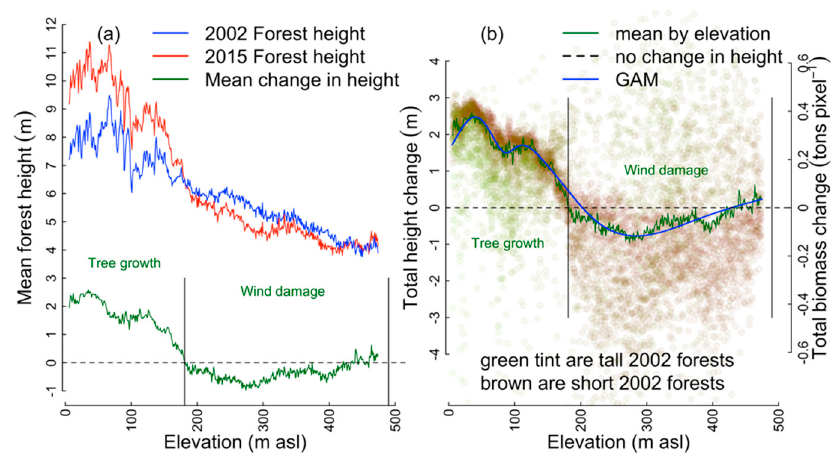
Figure 2. Standing tree height changes from 2002 to 2015 as indicated by differenced canopy height models (13m pixel CHMs). ( a ) Mean forest height in 13m pixels by elevation in 2002 (blue) and 2015 (red) and their difference (Height change, green, with axis shared with Mean forest height). ( b ) Total eight change from 2002 to 2015 by elevation and 2002 height. Total biomass change refers to change over 13 years. Tint of points shows mean forest height in 2002 with taller and shorter canopy heights tinted green and brown, respectively. Each point represents a 2002 height by elevation bin with change in height averaged across all pixels in the bin. Blue curve is simple GAM of ∆ H ~ s(Elevation), where s( ∙ ) is the GAM smoother.